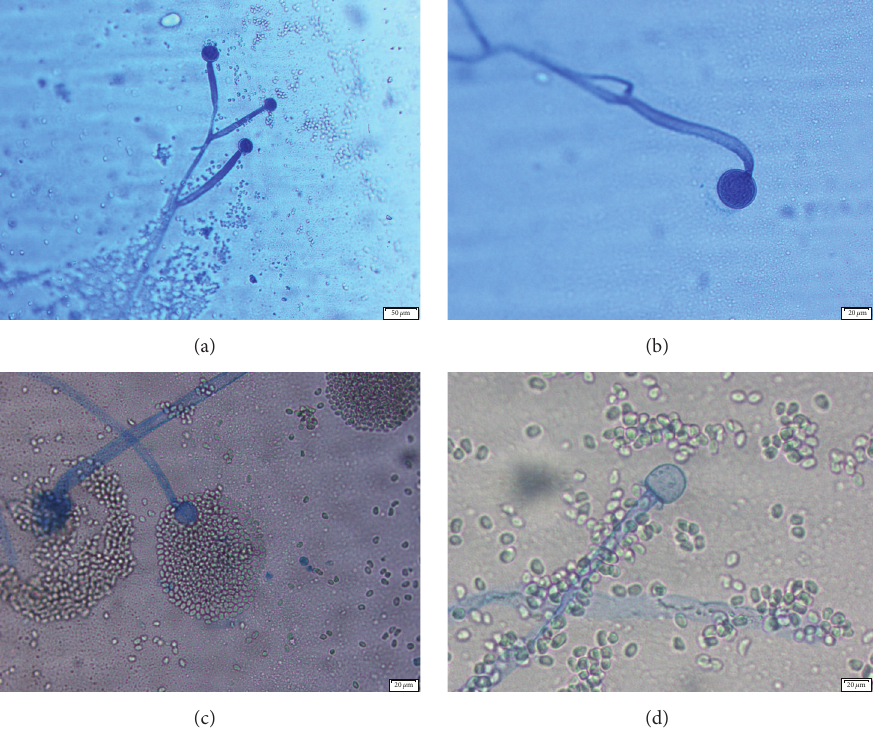
Figure 2: Microscopic examination of Mucor circinelloides on PDA by “tape prep” using lactophenol cotton blue stain. (a) Sympodially branched sporangiophores (100x magnification); (b) circinate sporangiophores (200x magnification); (c) deliquescent sporangia (100x magnification); (d) columella with collarette (200x magnification).